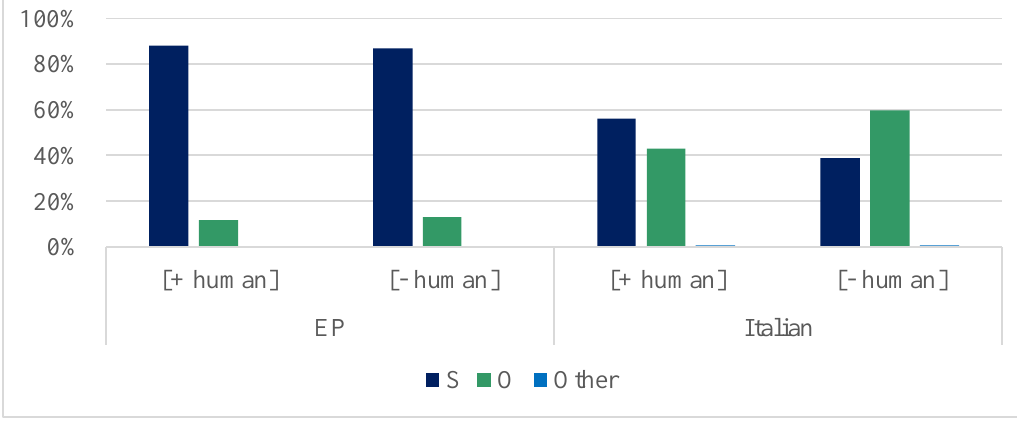
Figure 4. Interpretation of the null subject in the untimed task